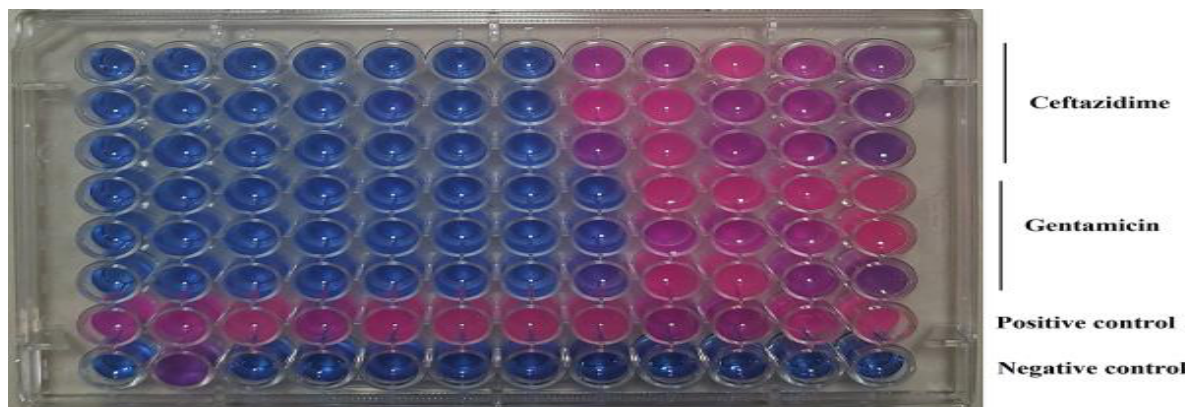
Figure. 2. Determination of MIC for Ceftazidime and Gentamicin against P . aeruginosa (ATCC